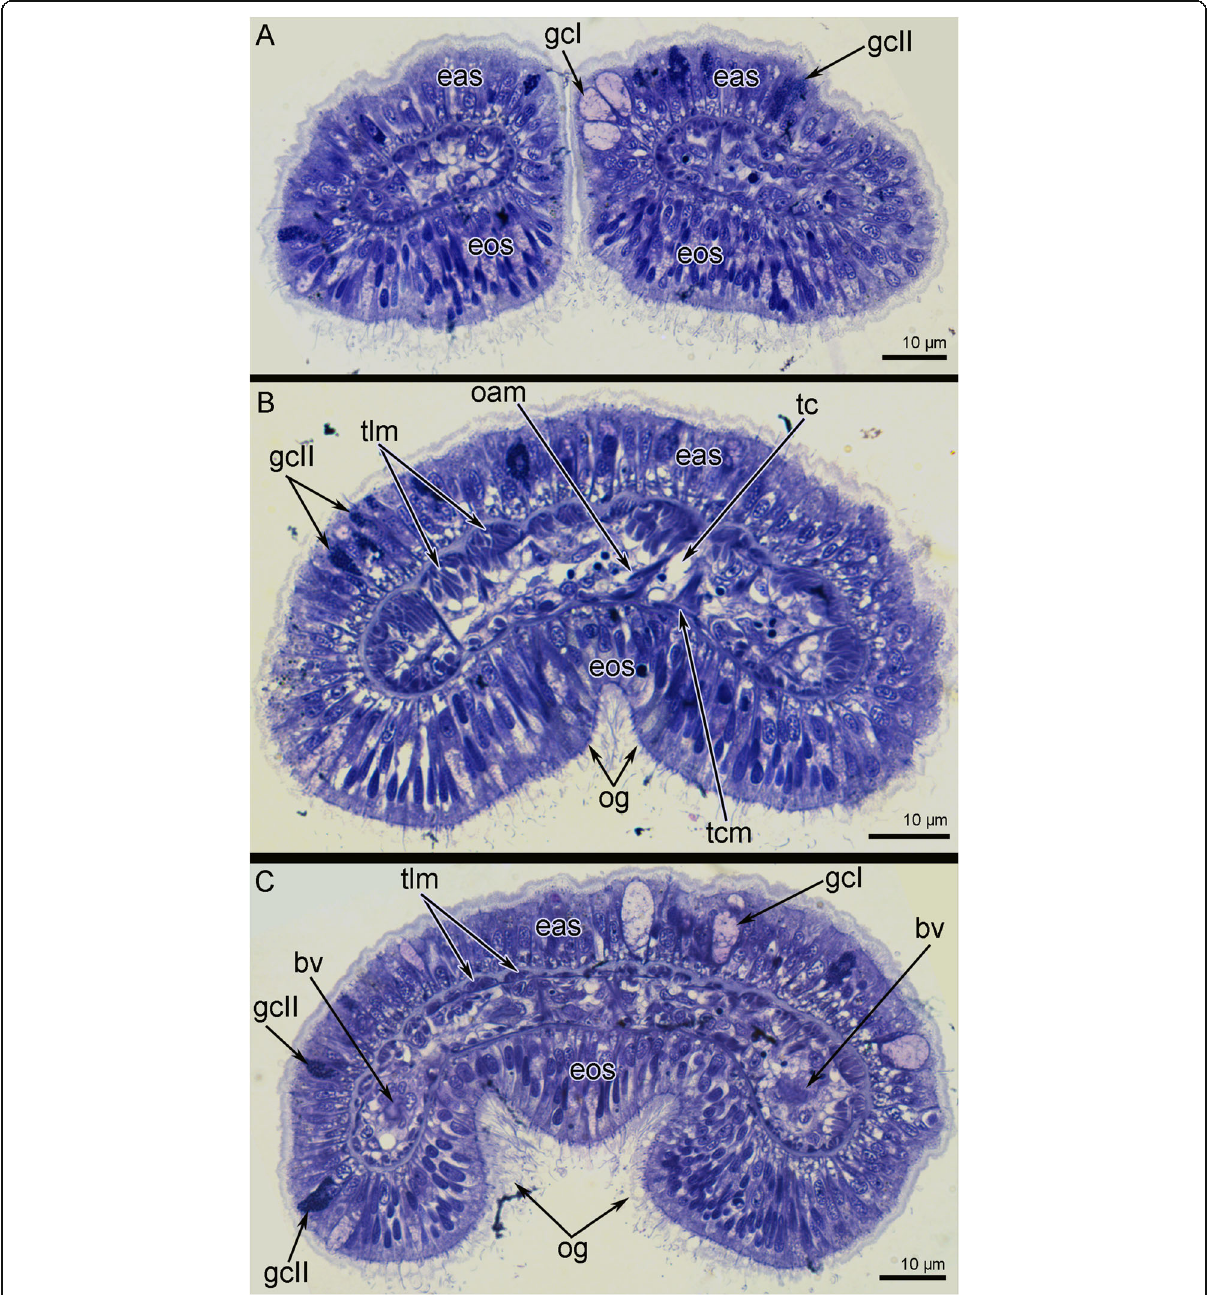
Fig. 2 Organization of tentacles of Owenia borealis . Transverse semi-thin sections at different levels of tentacles. A Forked tip of tentacle. B Middle portion of tentacle. C Base of tentacle. Abbreviations: bv – blood vessel; eas – epithelium of aboral side; eos – epithelium of oral side; gcI – gland cell of first type; gcII – gland cell of second type; oam – oral-aboral muscles; og – oral groove; tc – tentacle coelom; tcm – tentacle transverse muscle; tlm – tentacle longitudinal